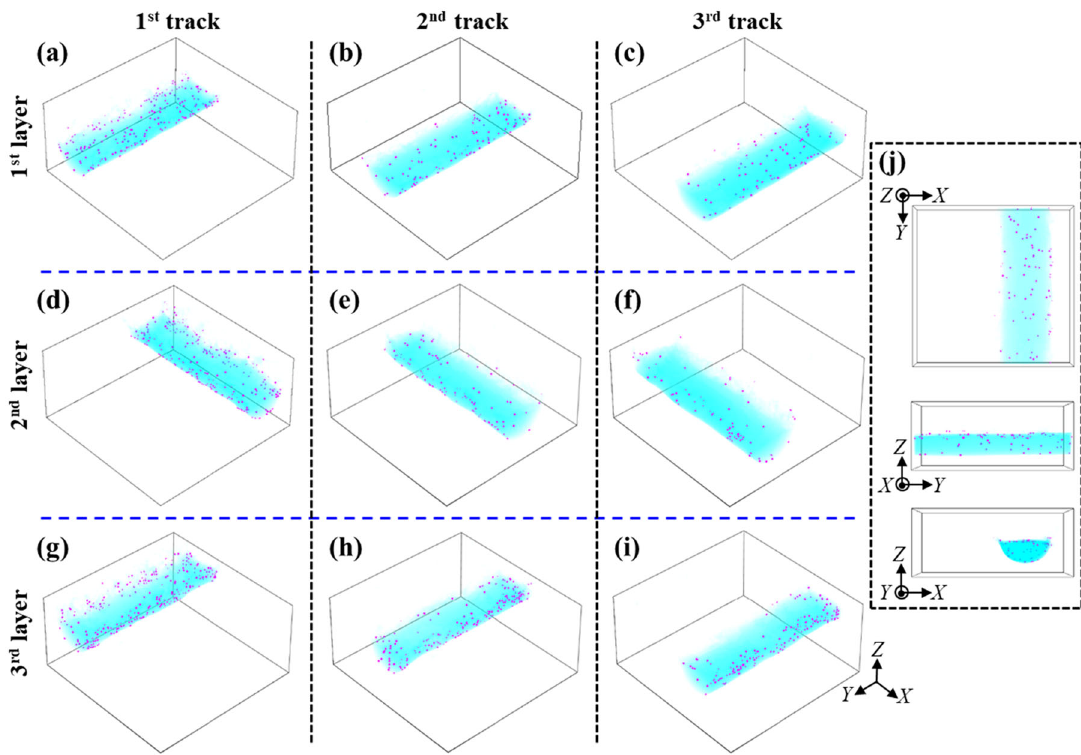
Fig. 7 Nucleation sites in each scanning track. The purple dots represent the nuclei and the blue areas indicate the scanning tracks. j is the 2D view of c .